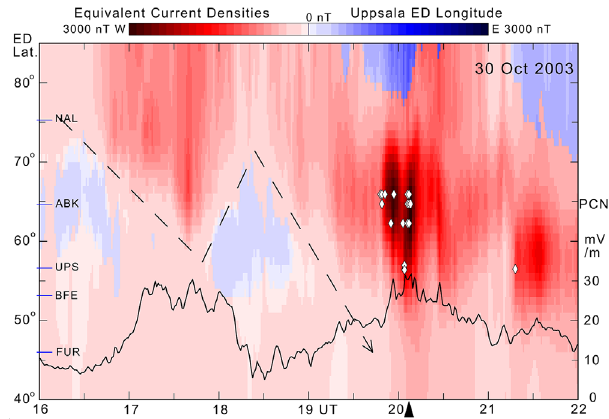
Fig. 6. Temporal development of equivalent overhead current density pro fi le at Uppsala (Lövö) magnetic longitude. At the left latitude scale the latitudes of a few relevant observatories are marked. Westward currents are marked by red colours in shades to indicate current intensities. Eastward currents by blue colours. The curve in full black line displays PCN index values with their scale to the right. The white diamonds indicate events of magnetic variations steeper than 10 nT/s. The dashed broken line indicates movements of current systems. The black triangle marks the power line cut.